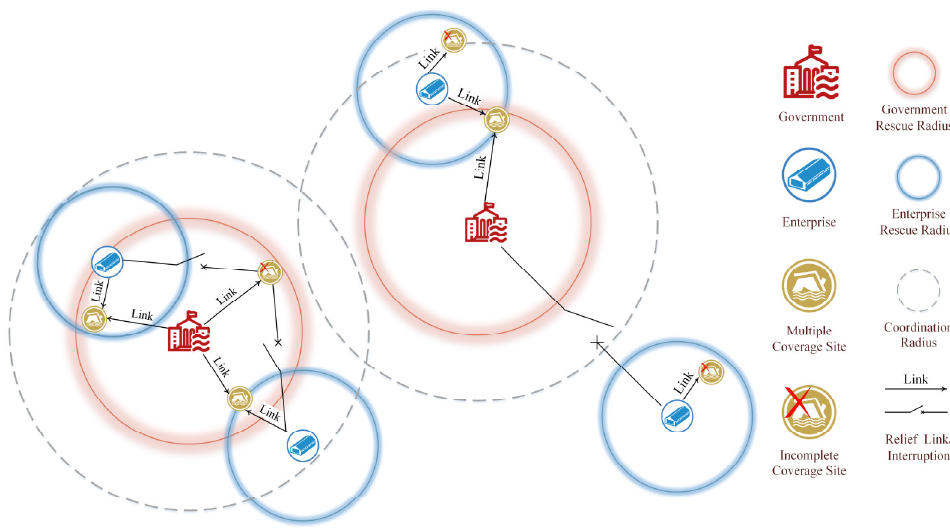
Figure 4. Coordination location of government warehouses and contract enterprises.